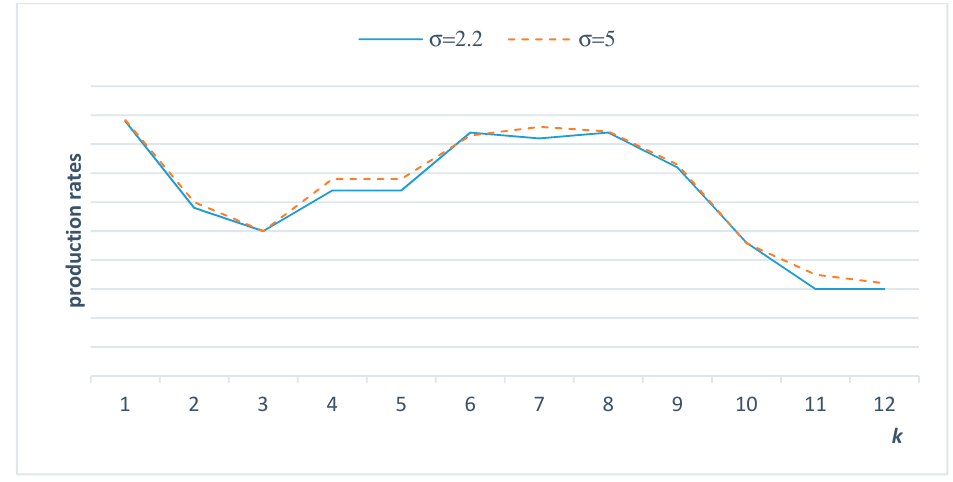
Figure 7. Production rates as a function of standard deviation, σ d